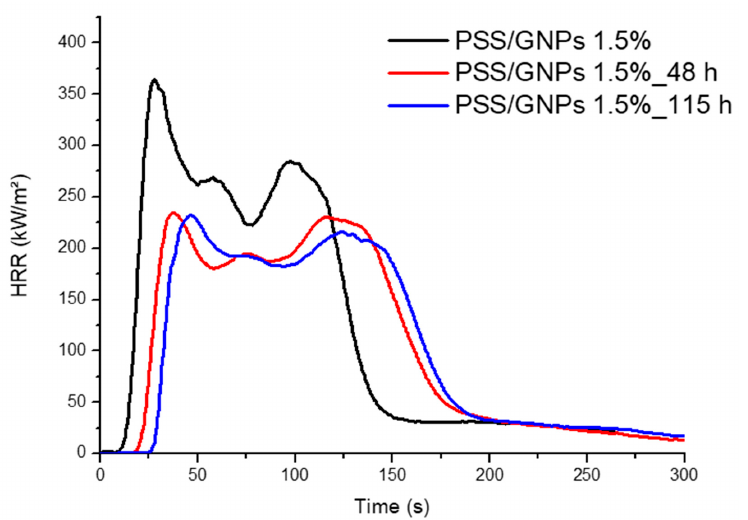
Figure 9. HRR vs. time curves for samples with 1.5 wt% of PSS/GNPs not aged and aged for 48 h and 115 h.